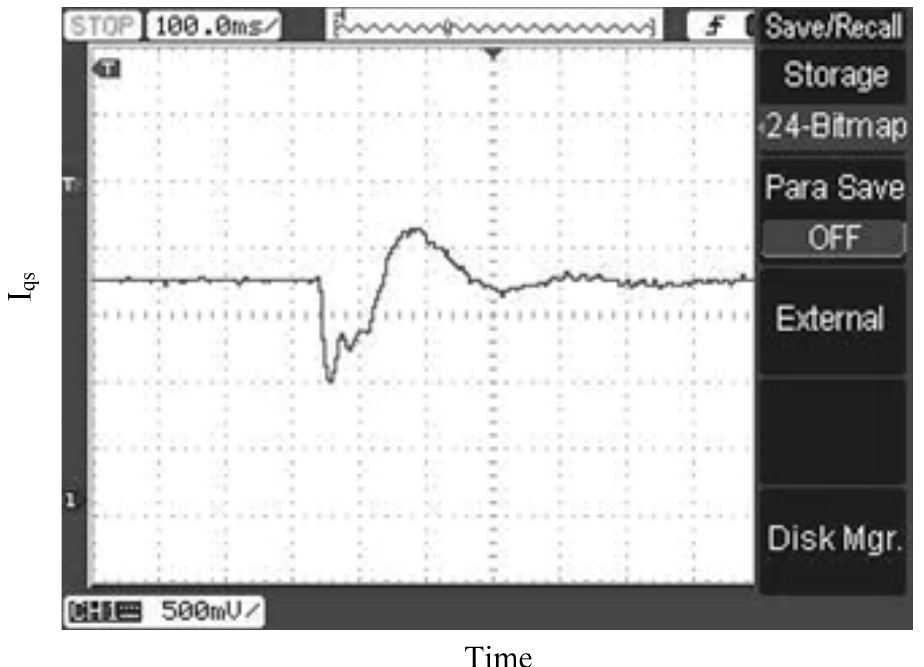
Figure 15. The transient performance of Iq S of the entire drive system under variable speed from 0.4 pu to 0.2 pu.